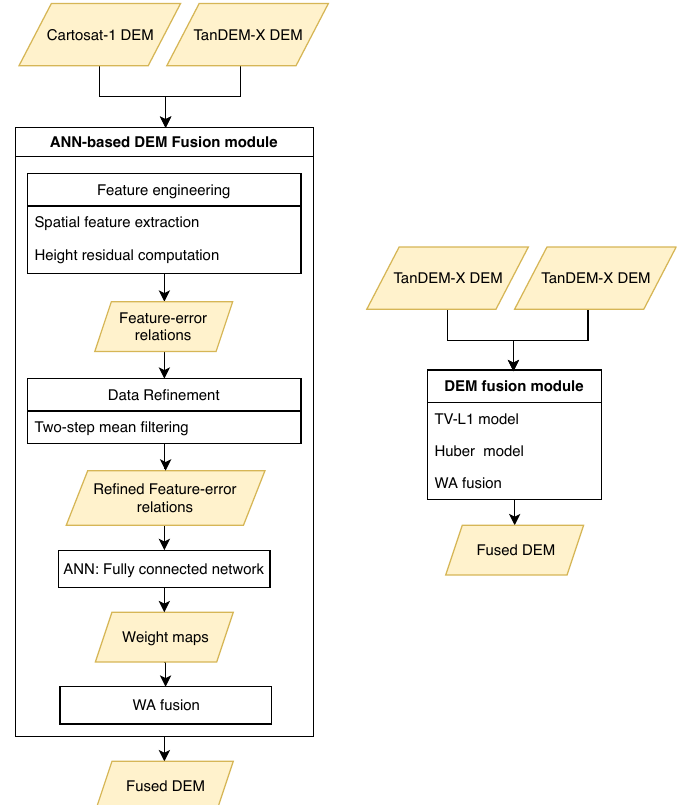
Figure 3. Different DEM fusion modules for improving the TanDEM-X quality. Left: The proposed pipeline for TanDEM-X and Cartosat-1 DEM fusion, Right: Process of multi-modal TanDEM-X DEM